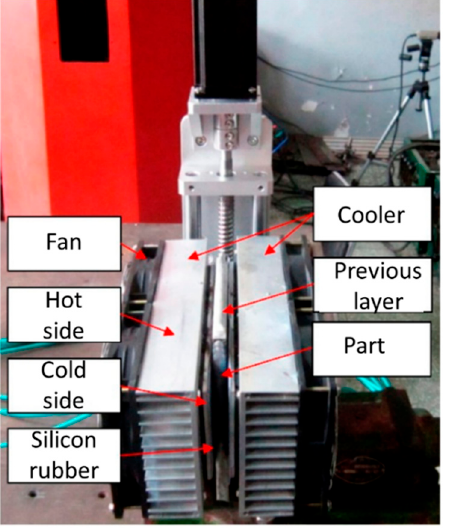
Figure 4. Representation of thermoelectric cooling setup (adapted from [32]).